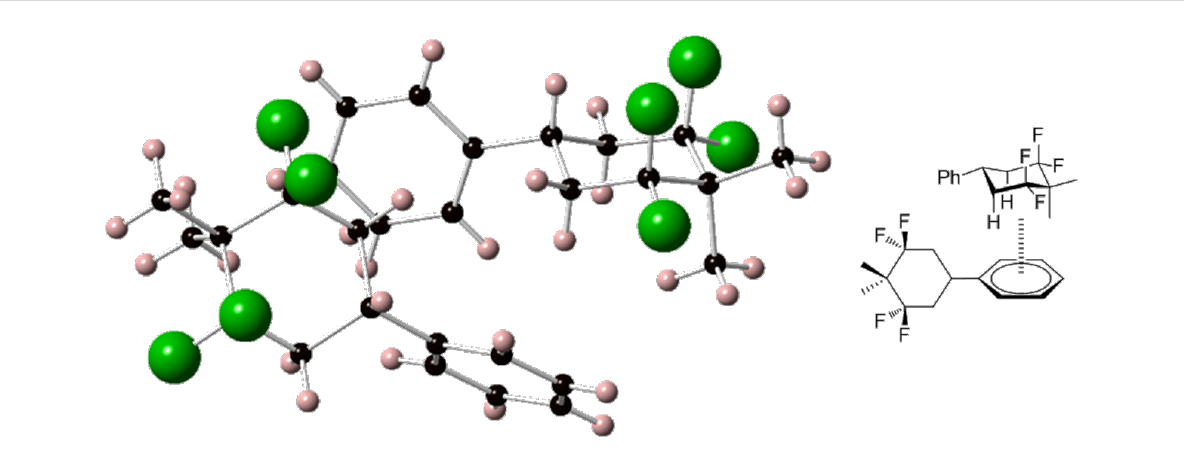
Figure 2: X-ray structure of compound 4c . The image shows two molecules stacked with the non-fluorine face pointing to an adjacent phenyl ring consistent with an electrostatic ordering. The structure has been deposited in the Cambridge Crystallographic Data Centre (CCDC)